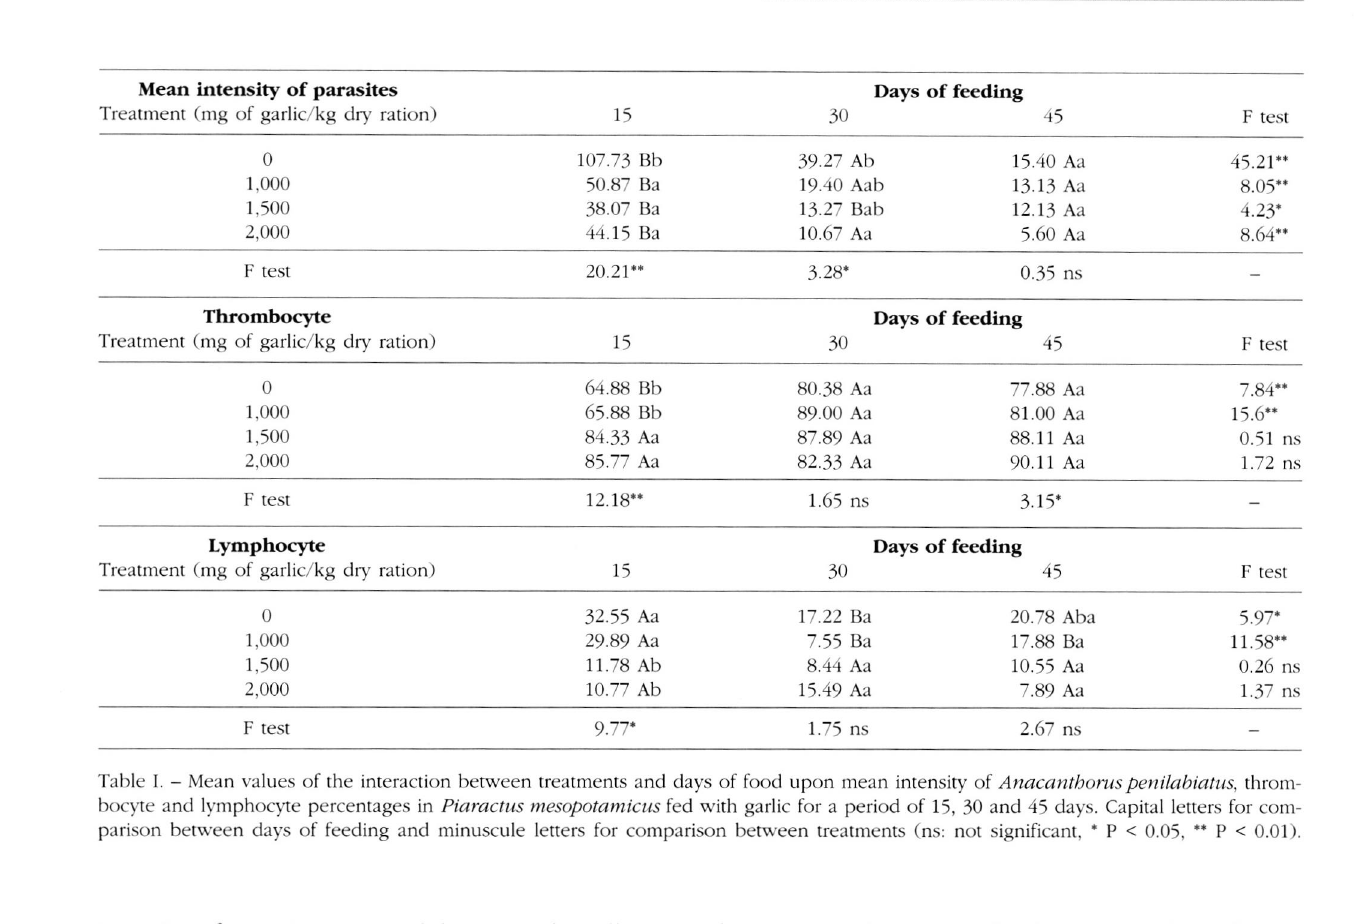
intensity of parasites A. penilabiatus in the gills